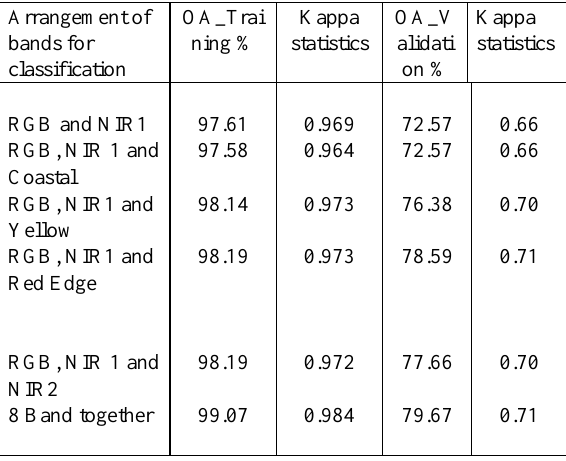
Table 2. Supervised classification of WORLDVIEW